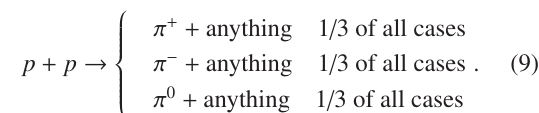
Figure 5. Cross-section over mass number as a function of the photon-energy in the nucleus rest frame. The data points show measurements of di ff erent isotopes, suggesting a univer- sal cross-section behaviour for all nuclei heavier than protons (orange curve). The gray curve represents the superposition Figure 4. Disintegration chain of 56 Fe in a GRB shell with the model, which approximates the nucleus’ cross-section by σ A γ = Z N colors representing the total energy per isotope in the SRF (see σ σ σ p γ + n γ with the proton and neutron cross-sections p γ and A A legend). White boxes correspond to energies lower than 10 44 σ n γ . Figure taken from [20]. erg s − 1 . The upper row shows the PSB model (left) and TALYS (right, CRPropa2 for the lighter elements), while the lower row shows the TALYS setup including di ff erent systematic assump- tions (see main text). The GRB parameters are L γ, iso = 10 52 erg s − 1 , Γ = 300, t v = 0 . 01 s, z = 2 and an E − 2 injection spectrum. Figure taken from [12].